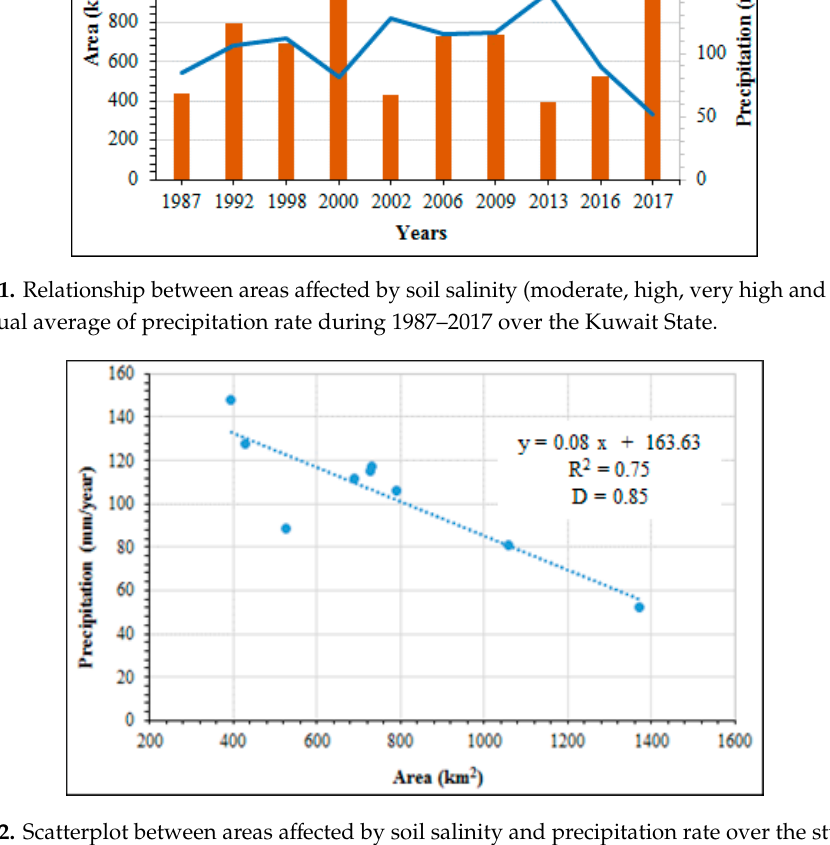
Figure 12. Scatterplot between areas affected by soil salinity and precipitation rate over the study area between 1987 and 2017 ( p ˂ 0.05).